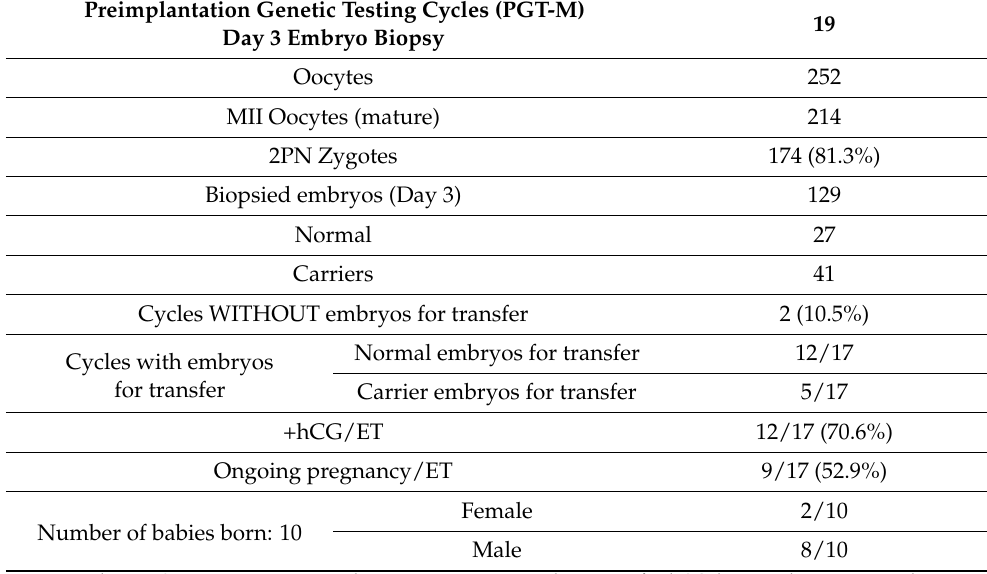
Table 1. Clinical outcome of PGT-M cycles. Preimplantation Genetic Testing Cycles (PGT-M)